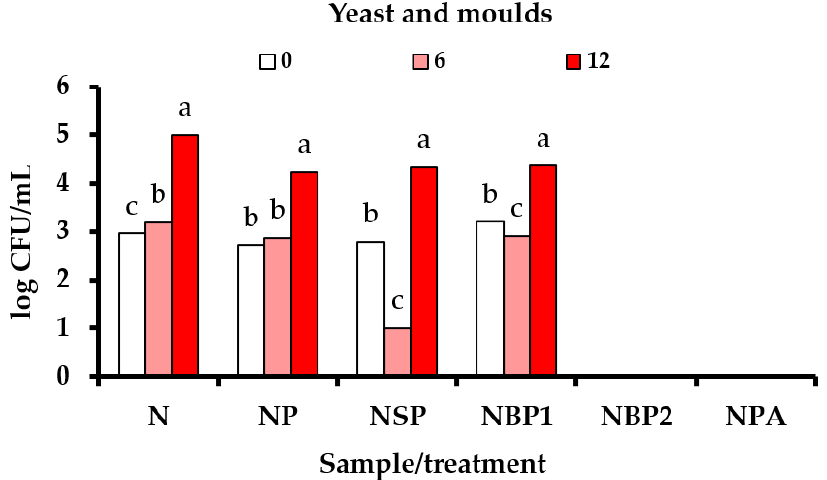
Figure 1. The average counts (log CFU/mL) of yeast and moulds in rose hip nectars during 12 days of refrigerated storage. Data were analysed by post-hoc Tukey test, with the significance defined at p < 0.05.